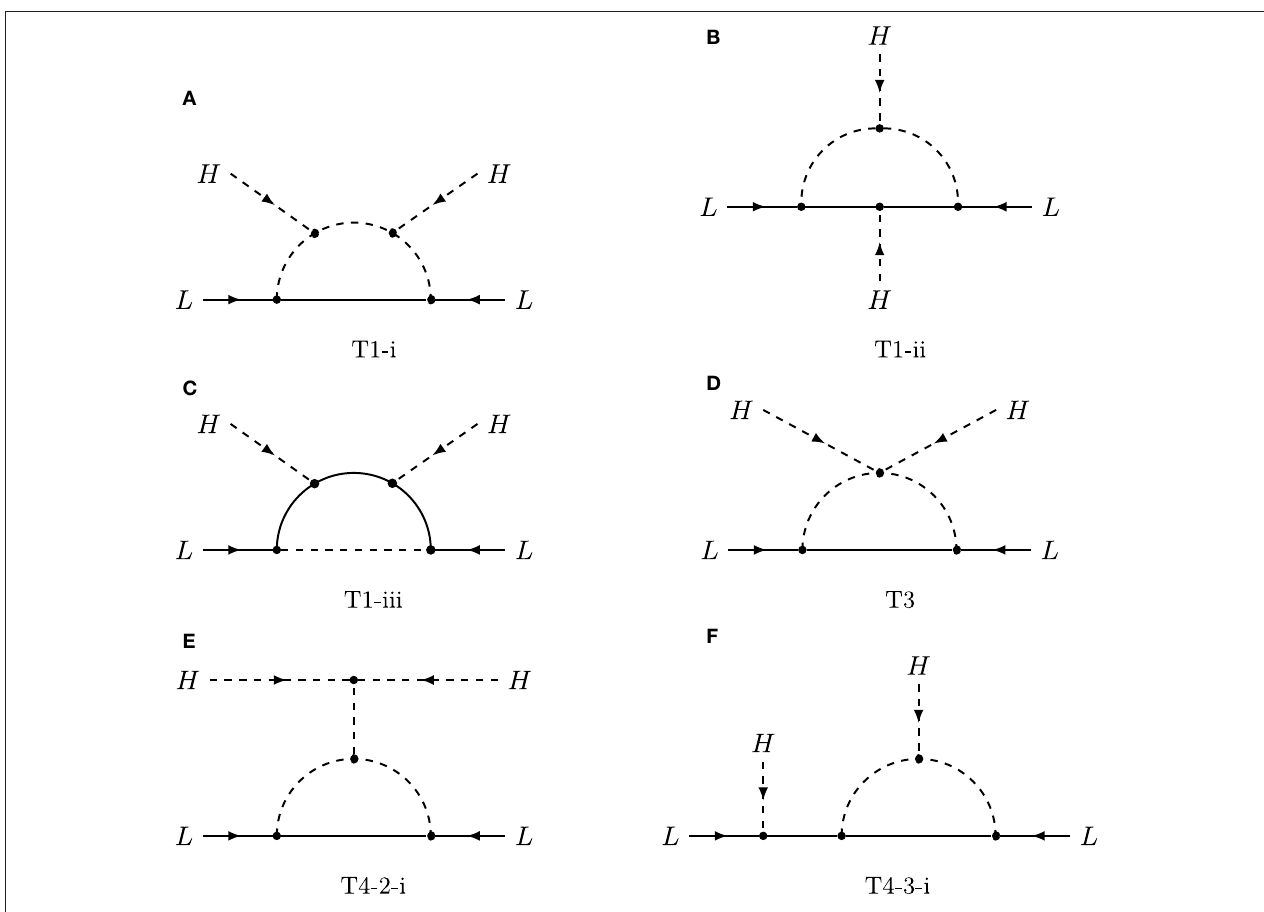
LLHH . Dashed lines could be scalars or =